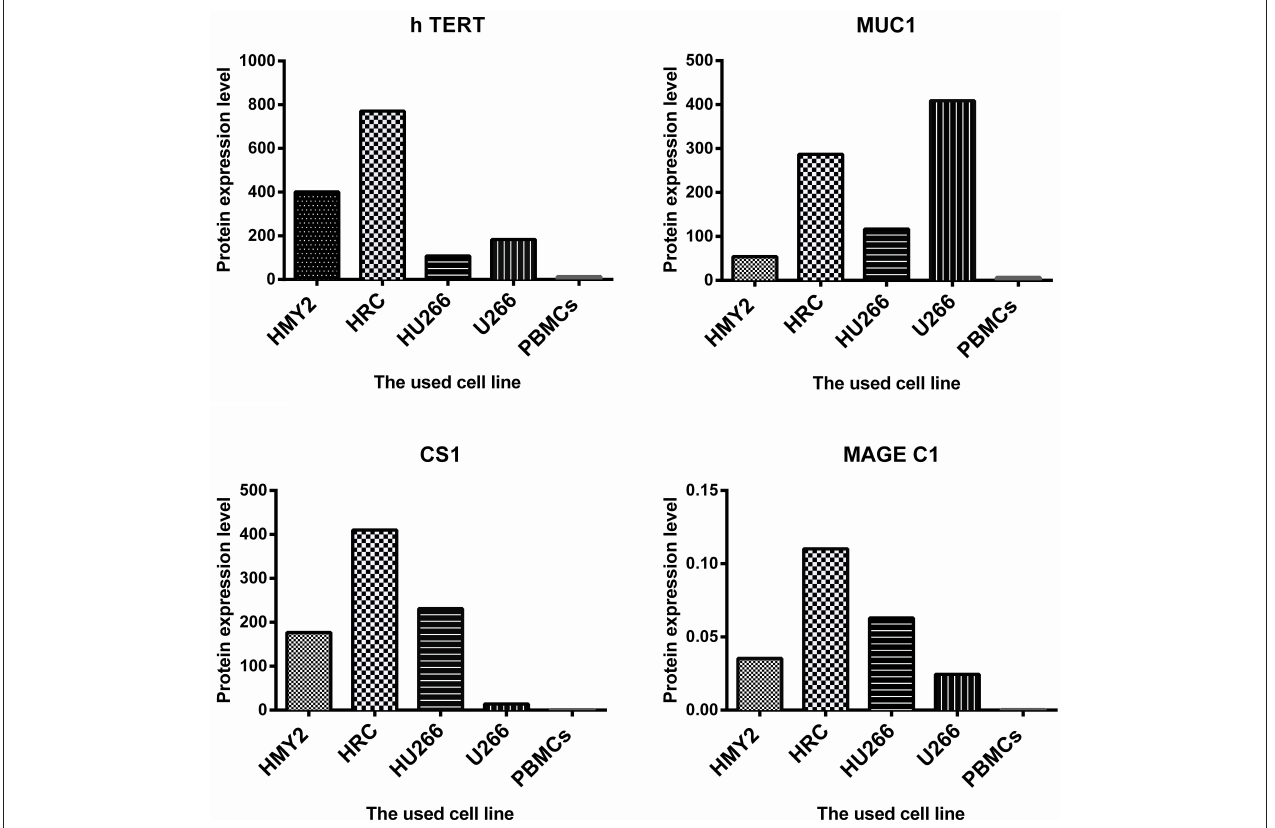
FIGURE 2 | The level of protein expression of the indicated antigens by the used cell lines. For MUC1, h TERT, and CS1, the presented values are the MFI of FACS analysis (means of two). For MAGE C1, the values were determined by imaging densitometry following Western blot (mean of two). The presented MFI values are (the MFI of examined marker expression—MFI of matched isotype